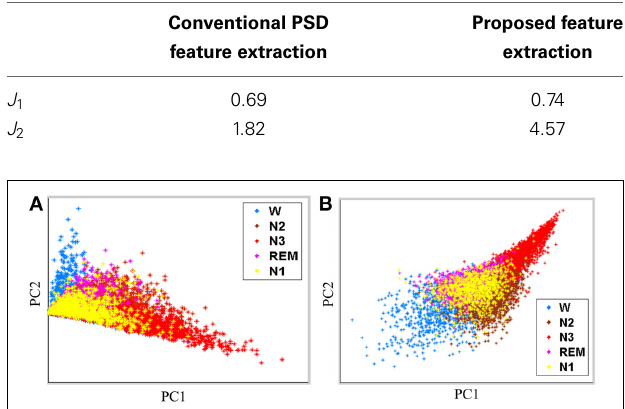
Table 2 | Separability measurements by using Fisher criterion for the conventional PSD feature extraction and the proposed feature extraction approach.